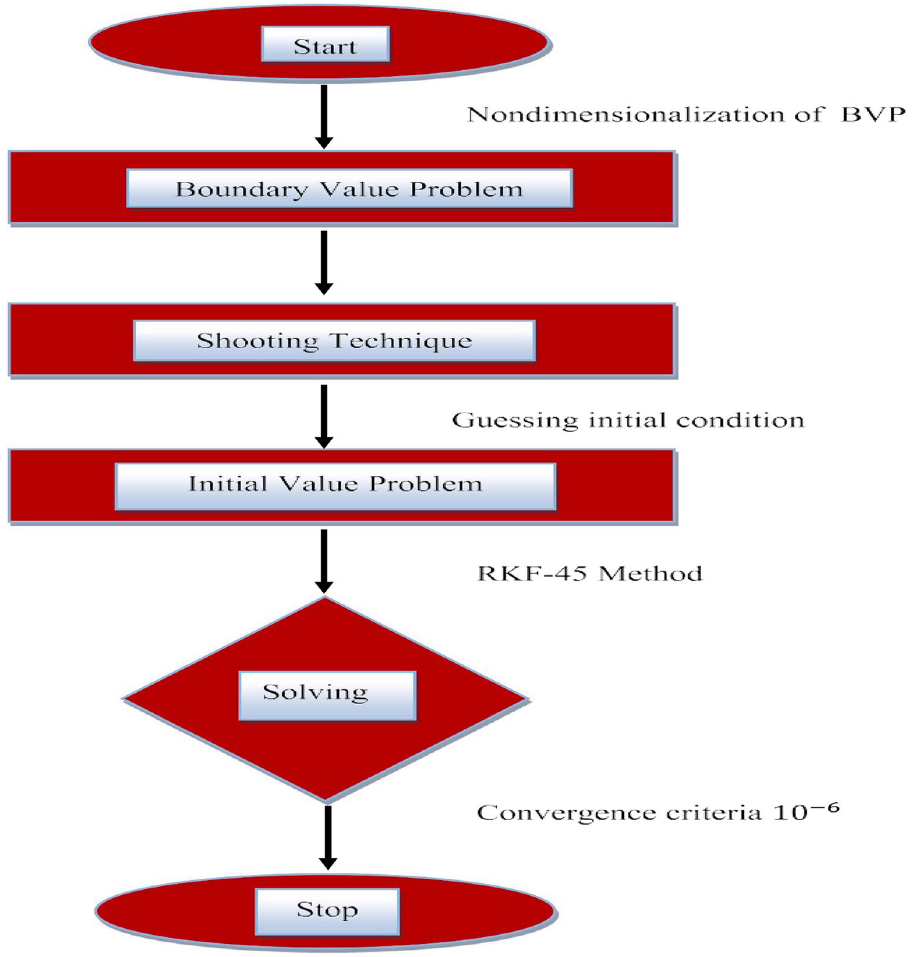
Figure 6. Solution procedure.